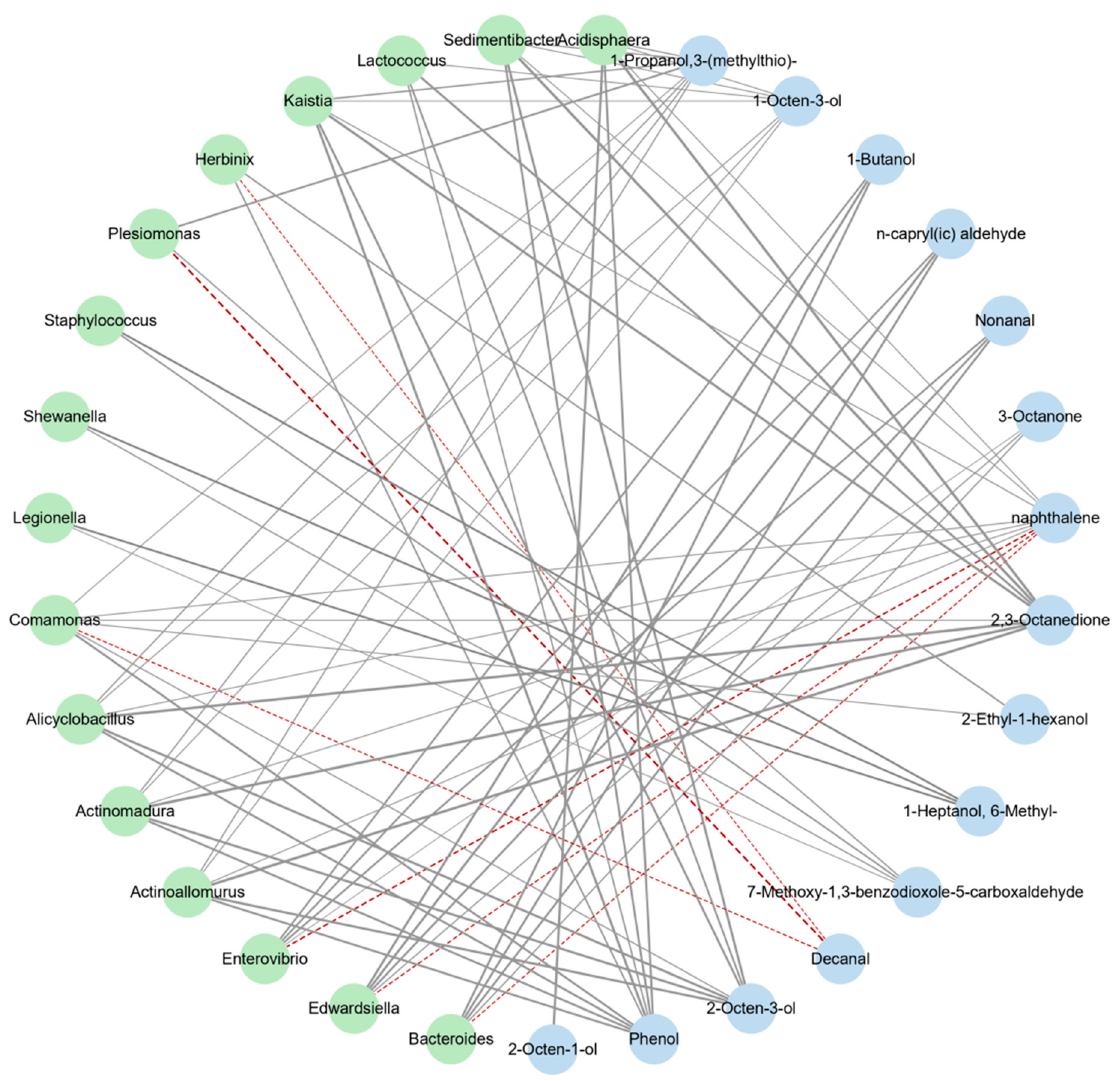
Figure 8. The correlation network analysis plot of the intestinal flora and volatile flavor compounds. Negative correlation (red dotted line). Positive correlation (gray solid line).